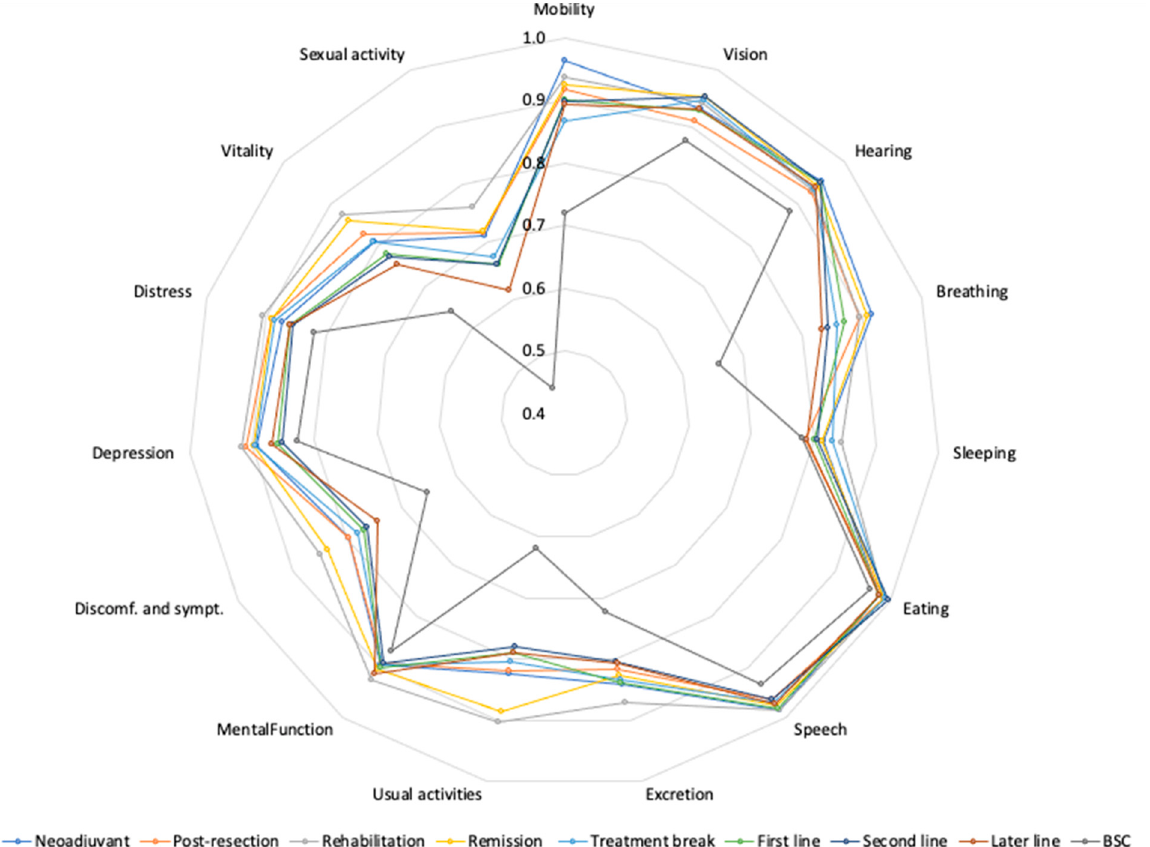
Figure 3. The mean 15D profile in different treatment phases. Abbreviations: Discomf. and sympt. = Discomfort and symptoms, BSC = Best Supportive Care.